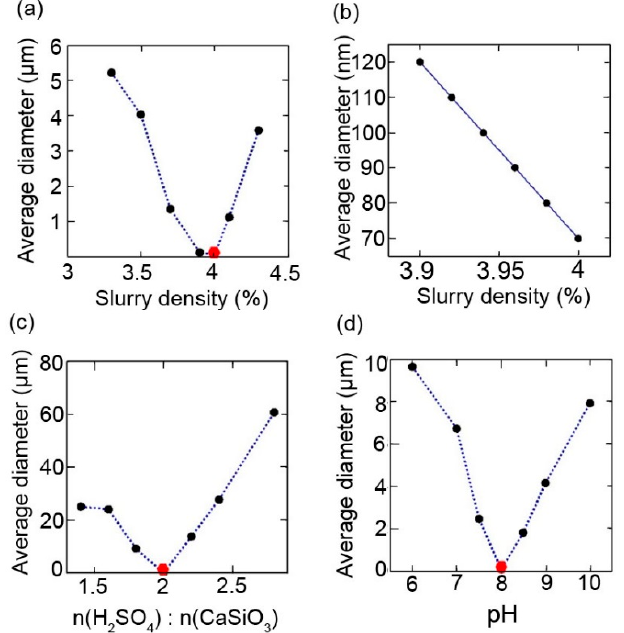
Figure 2. ( a , b ): The average diameter of nanoparticles with different concentrations of CaCO 3 slurry with other reagents held at the standard conditions. ( c ) The average diameter of nanoparticles with a different molar ratio of H 2 SO 4 to CaSiO 3 with other reagents held at the standard conditions. ( d ) The average diameter of nanoparticles with different pH value with other reagents held at the standard conditions. The red hexagon indicated the average diameter of nanoparticles synthesized at the standard conditions. The average diameter at this point is 70 nm.